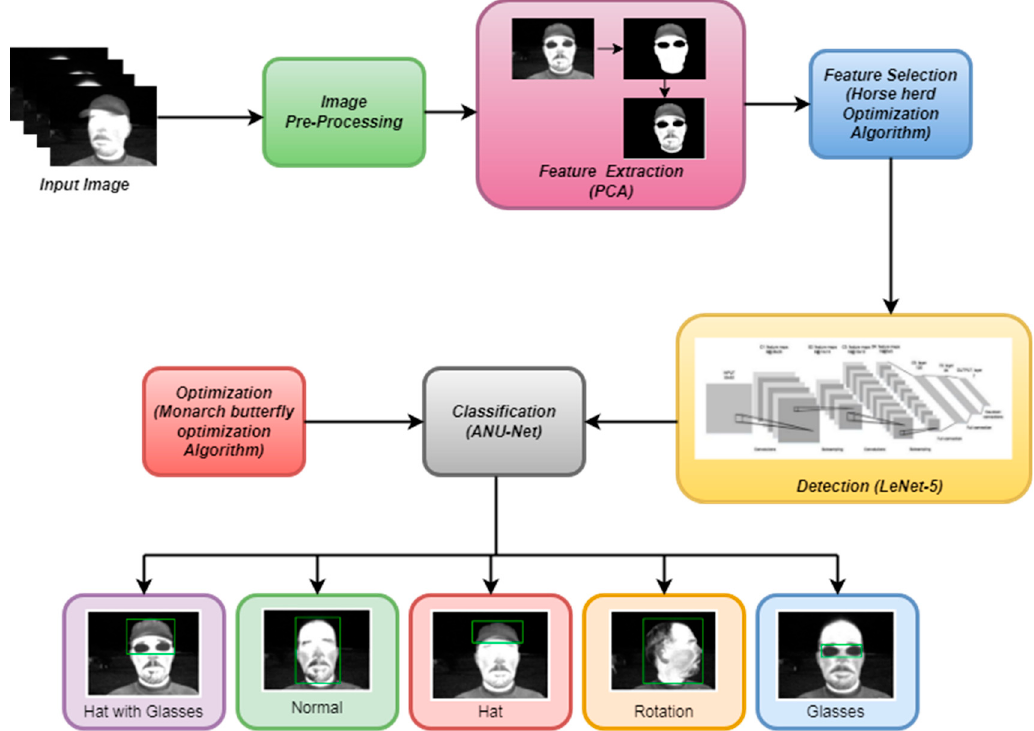
Figure 2. The architecture of the proposed method.